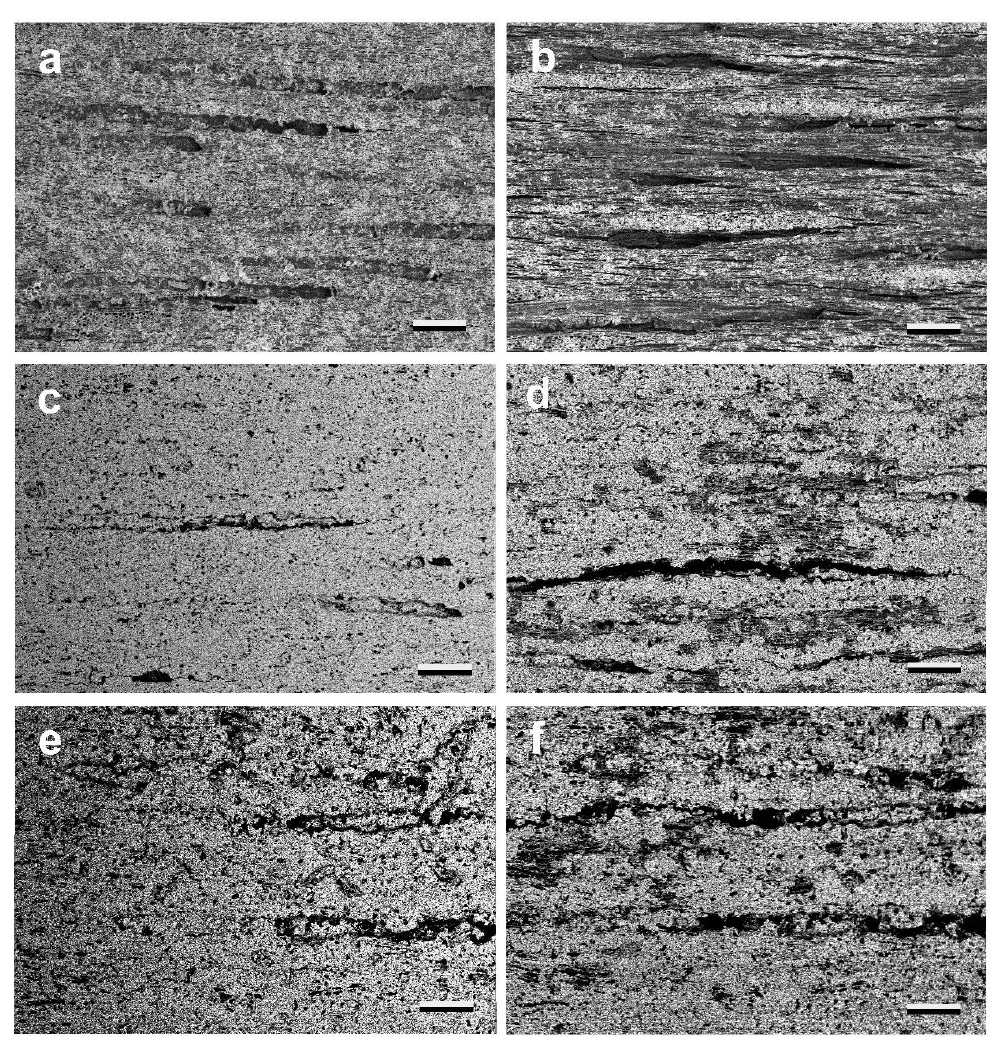
Figure 1. SEM micrographs of the stained mock-ups before the cleaning treatment ( a , c , e ) and of the same mock-ups after the 8th application of DFO-B at pH 8.6 ( b ), DFO-B at pH 6.5 ( d ) and DFO-B in EtOH ( f ), respectively. All scale bars = 100 μm.